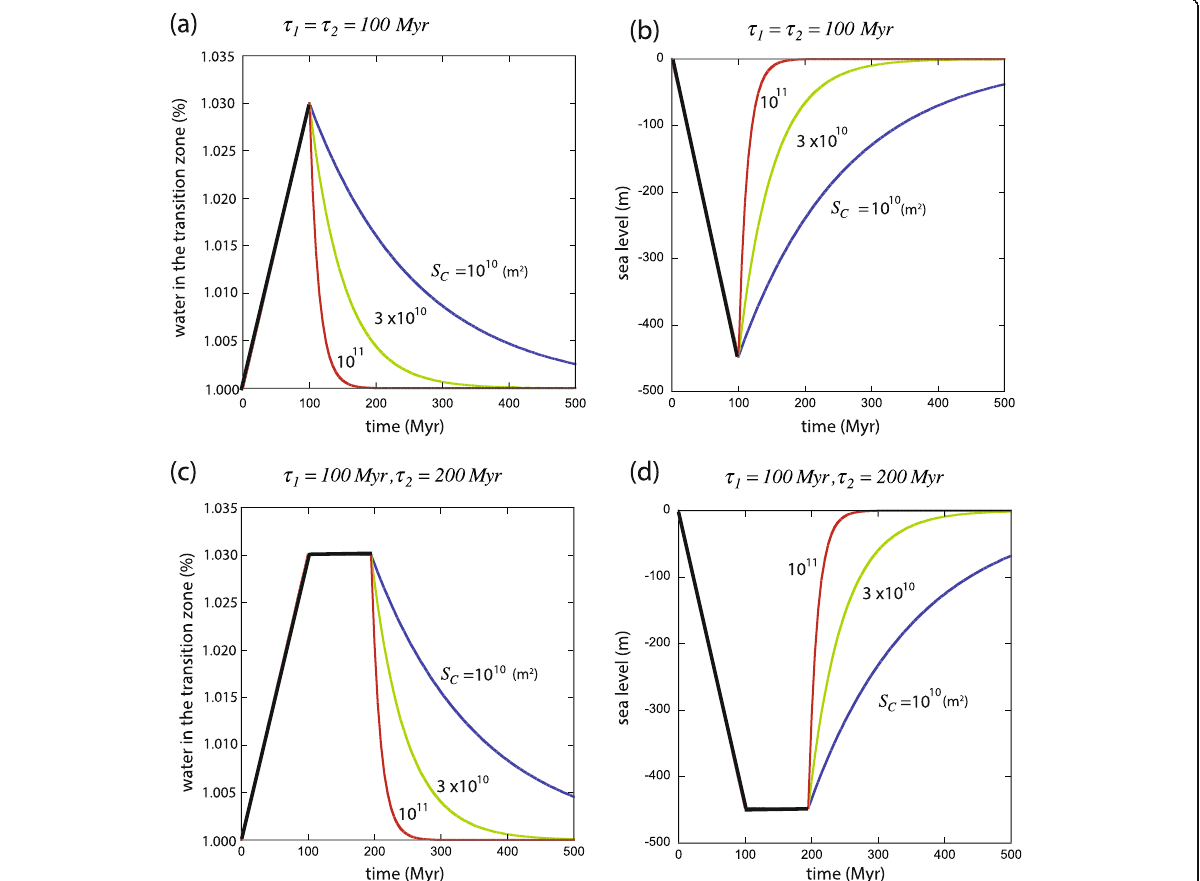
Fig. 13 Results of model calculations on ocean mass history. Regassing parameters (rate of regassing and duration of regassing pulse ( τ 1 )) are chosen to reproduce the inferred rapid sea-level drop (2 – 3 m/Myrs (in the last ~ 100 Myrs); Fig. 6). Degassing parameters include the area of cool regions with excess degassing ( S C ) and the delay time ( τ 2 ) for degassing since the beginning of excess regassing (and the plume upwelling velocity (~ 1 m/year)). a History of the water content in the MTZ ( τ 1 = τ 2 =100 Myrs). b Sea-level change corresponding to the model shown in ( a ) using a relation \( \Delta z\approx -\overline{z}\frac{M_{MTZ}\Delta {X}_{MTZ}}{W_{\mathrm{ocean}}} \) ( Δ z : sea-level change, \( \overline{z} \): average depth of the oceans (= 3730 m), M MTZ : mass of the MTZ (= 4 × 10 23 kg)), Δ X MTZ : change in the water content of the MTZ; W ocean : mass of oceans (=1.4 × 10 21 kg)). b Same as ( a ) except that τ 1 =100 Myrs, and τ 2 =200 Myrs. c Same as ( b ) except that τ 1 =100 Myrs, and τ 2 =200 Myrs. Observed sea-level changes (Fig. 7) can be explained with S C =(3 – 10) × 10 10 (m 2 ) (i.e., a region with 200 – 350 km